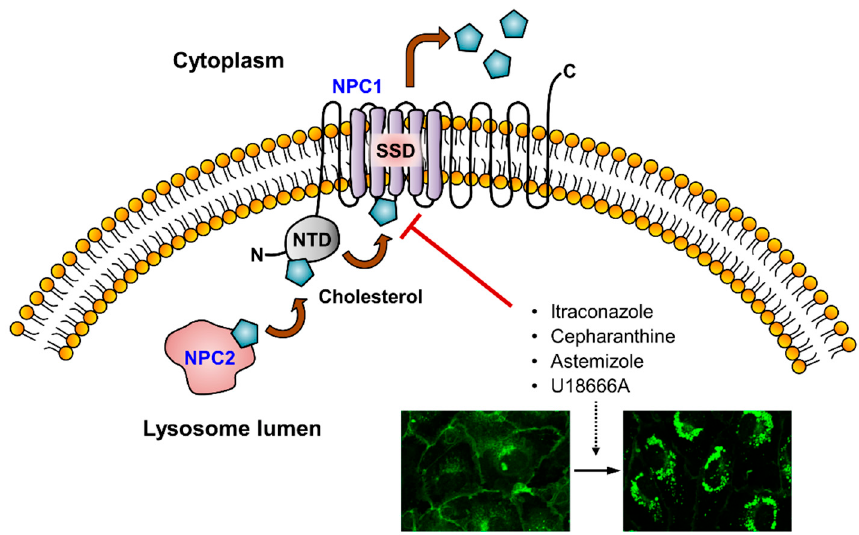
Figure 2. Cholesterol transport in the lysosome. Upon being delivered to the lysosome, LDL and cholesteryl esters are hydrolyzed by lysosomal acid lipase (LAL). Unesterified cholesterol in the lysosome lumen binds to Niemann-Pick disease type C (NPC) NPC2 and is then transferred to the N-terminal domain (NTD) of NPC1 in the inner-membrane side of the lysosome. Cholesterol is transferred from the NTD to the sterol-sensing domain (SSD) of NPC1 and transported out of the lysosome. Several cholesterol trafficking inhibitors including itraconazole, cepharanthine, and astemizole, as well as U18666A, are known to bind to the SSD and interfere with the cholesterol transport by NPC1. This effect leads to an accumulation of free cholesterol inside the lysosome. The immunofluorescence images are from endothelial cells stained with filipin (cholesterol-specific fluorescent dye). The left immunofluorescence image is control HUVEC with a high level of cholesterol in the cell membrane and other intracellular compartments. The right one is an example of HUVEC treated with cepharanthine, showing the strong accumulation of cholesterol in the lysosomes and the depletion of cholesterol in other cellular compartments.